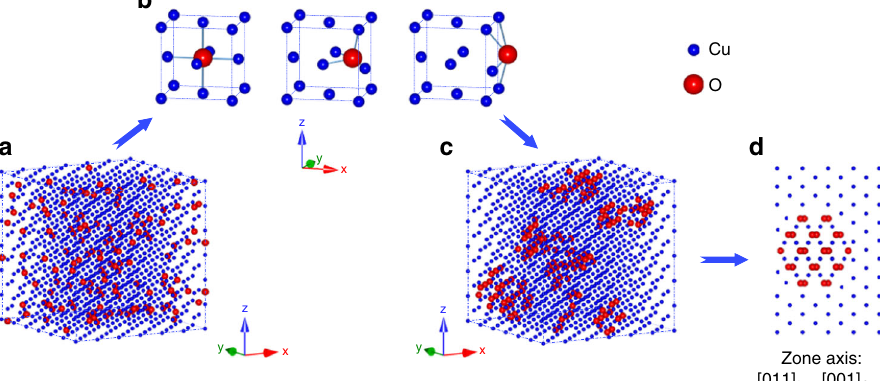
Fig. 5 Schematic diagram of the oxidation process. a As-deformed state with oxygen randomly distributed in fcc matrix. b Oxygen movement from one octahedral center to another. c O-rich nanoclusters formation inside the fcc matrix. d Formed CuO with zone axis of [001] CuO embedded inside fcc matrix with zone axis of [011]